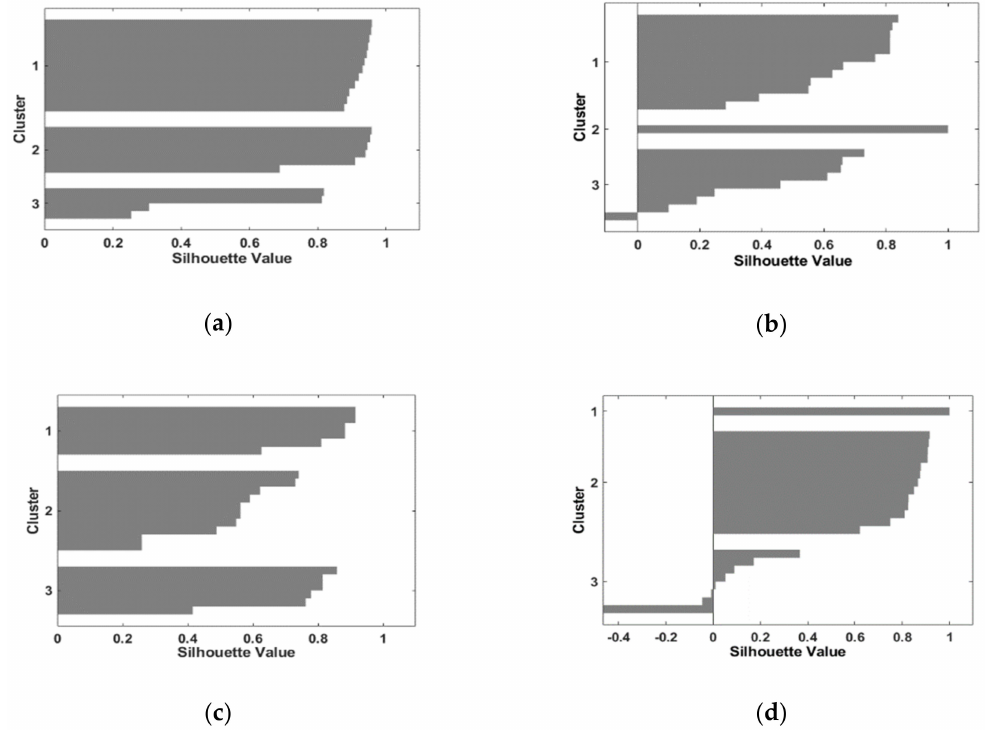
Figure 5. Cluster validity for S-Jaccard values for raw images belonging to D1. The name of the images follows the pattern: Diagnose Index / MRI image type. ( a ) S-Jaccard_ healthy / T2w; ( b ) S-Jaccard_ glioma / T2w; ( c ) S-Jaccard_ healthy / PD; ( d ) S-Jaccard_ glioma /